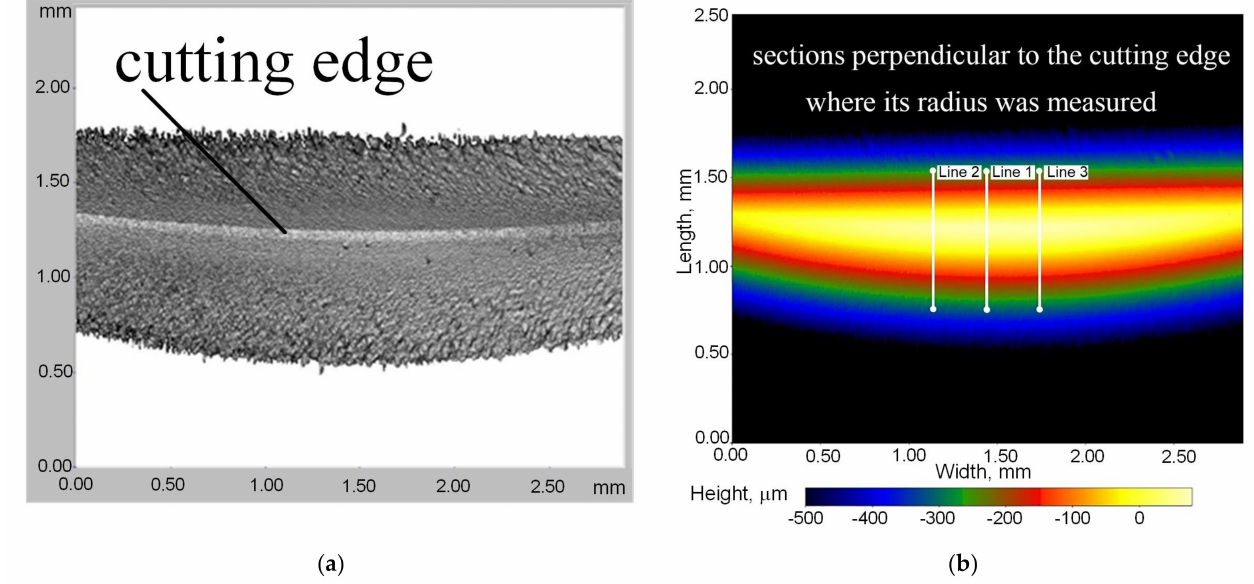
Figure 10. The cutting edge of the plate: ( a ) image from an optical 3D scanning camera; ( b ) topography of the cutting